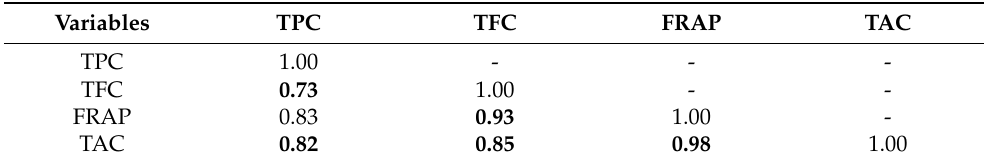
Table 4. Pearson’s correlation coefficients for the total phenolic content (TPC), total flavonoid content (TFC) and antioxidant capacity (FRAP and TAC) of extracts from avocado peel. Significant correlations are marked in bold. Variables TPC TFC